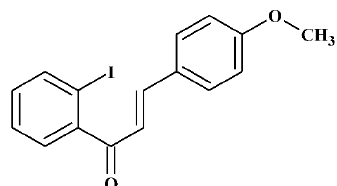
(cid:48) -methoxychalcone